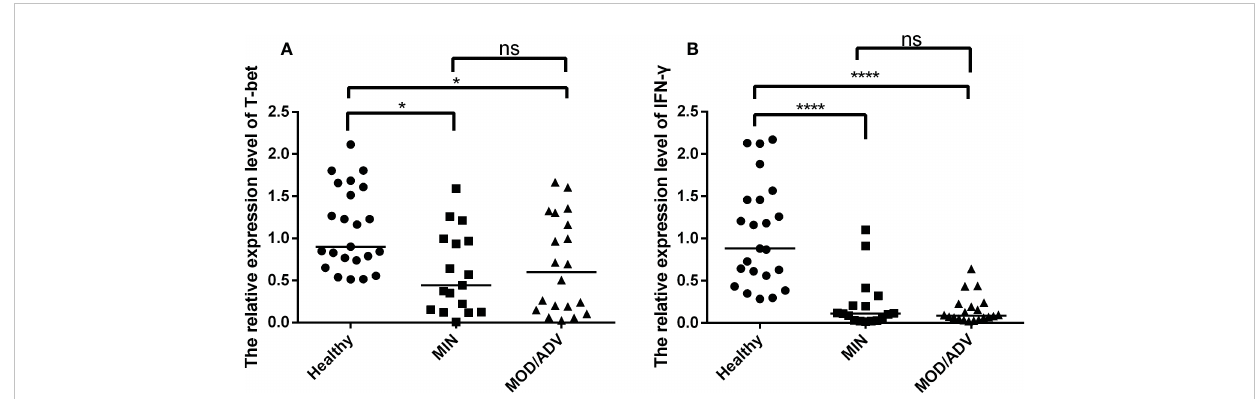
FIGURE 4 Comparison of the mRNA expression of T-bet and IFN- g in healthy ( n =23), mild ( n =17) and moderate/severe ( n =20) patients, performed by Kruskal- Wallis ’ s test. The normalization of data were used the internal control gene b -actin and presented as the mean ± SD of three technical replicates. (A, B) , respectively, show the mRNA expression of T-bet and IFN- g in different individuals groups. * p < 0.05, **** p < 0.0001, ns , not signi fi